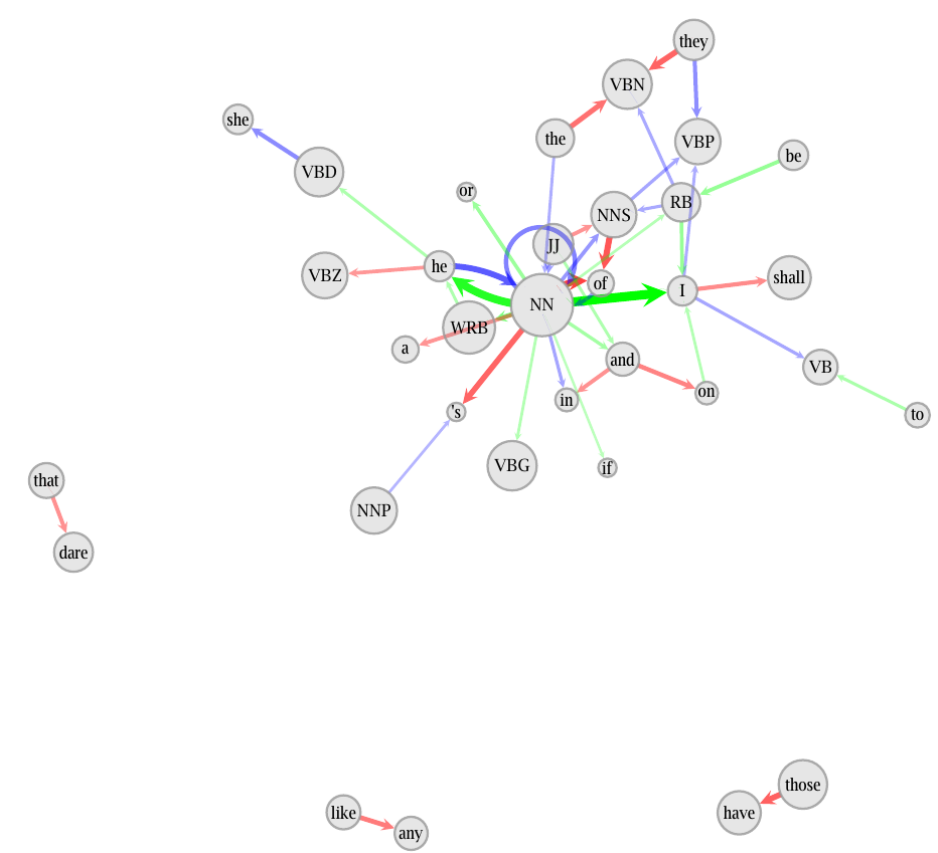
Figure 6. Comparative bigram graph for Bloom’s, Stephen’s, and Molly’s thoughts. Blue arrows indicate over-representation in Bloom’s thoughts, red arrows indicate over-representation in Stephen’s thoughts, green arrows indicate over-representation in Molly’s